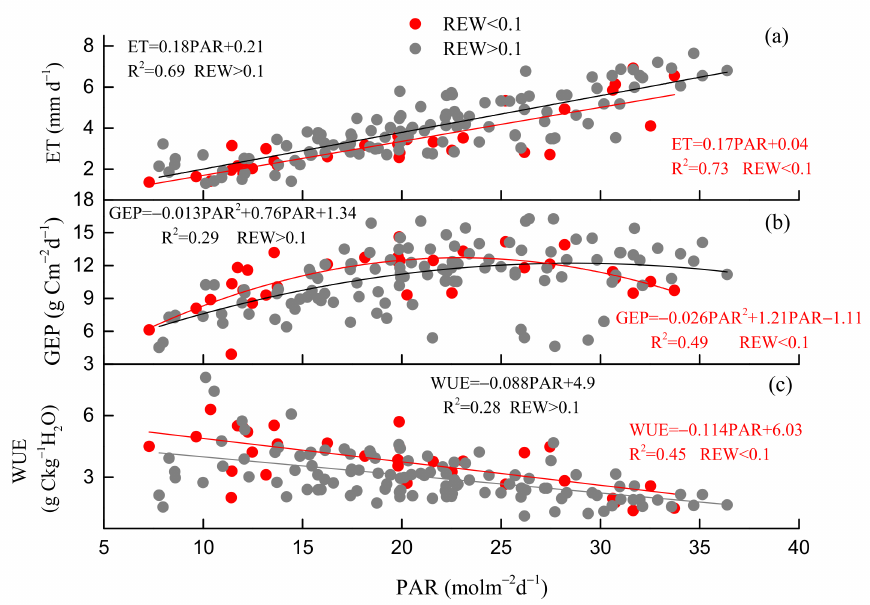
Figure 9. Responses of daily ( a ) evapotranspiration (ET), ( b ) gross ecosystem productivity (GEP) and ( c ) water use efficiency (WUE) to photosynthetically active radiation (PAR) under two kinds of relative extractable water content (REW) levels (REW > 0.1 and REW < 0.1) during the summer in 2017–2019.